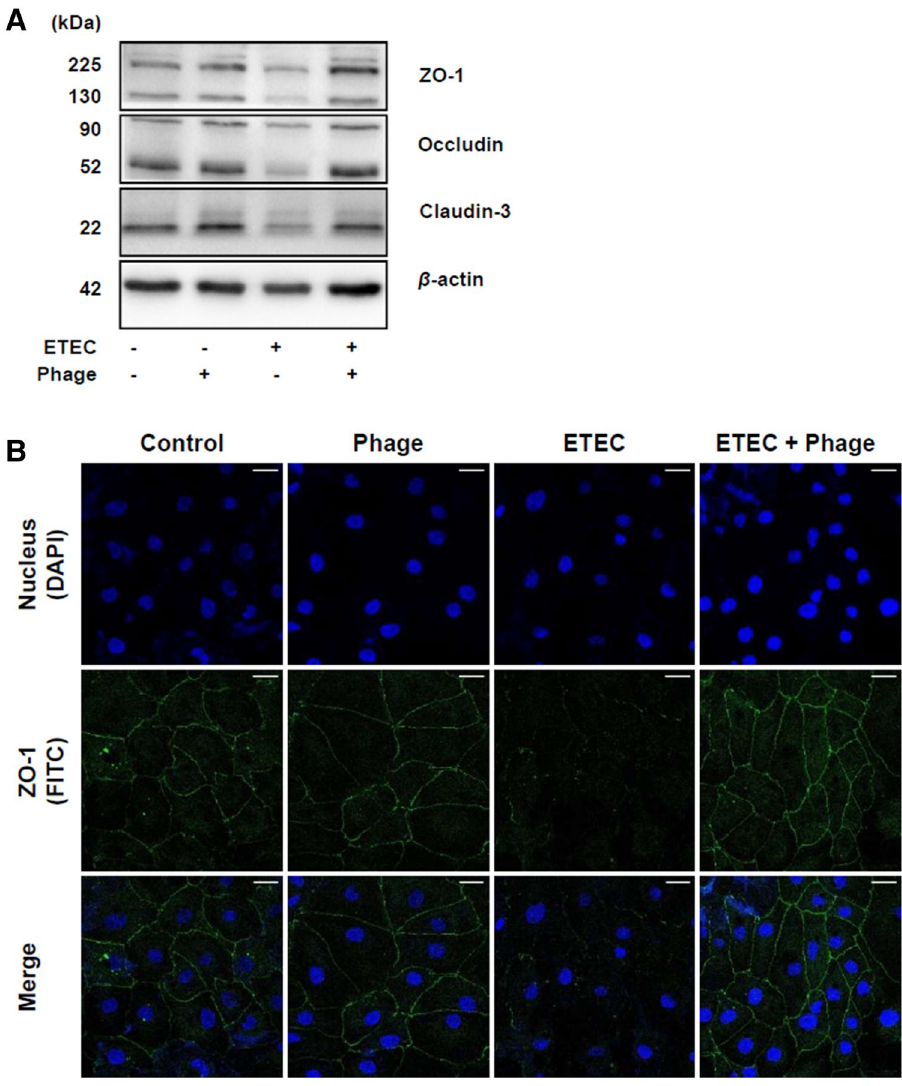
Figure 2. Phage EK99P-1 restored the decreased expression of tight junction proteins by ETEC in IPEC-J2 infected with ETEC K99. A monolayer of confluent IPEC-J2 was treated with ETEC K99 (2 × 10 6 cfu/mL) and phage EK99P-1 (2 × 10 5 pfu/mL) for 3 h. ( A ) Whole-cell lysates were analyzed for the expression of ZO-1, occludin, claudin-3, and β -actin using anti-claudin-3, -occludin, -ZO-1 and -β-actin antibodies by western blot assay (n = 3). Full-length blots/gels are presented in Supplementary Fig. 4. ( B ) ZO-1 expression in IPEC-J2 was visualized using confocal microscopy after staining with anti-ZO-1 antibody conjugated with Alexa Fluor 488- FITC (green) and nuclei with DAPI (blue) (n = 3). Scale bar = 30